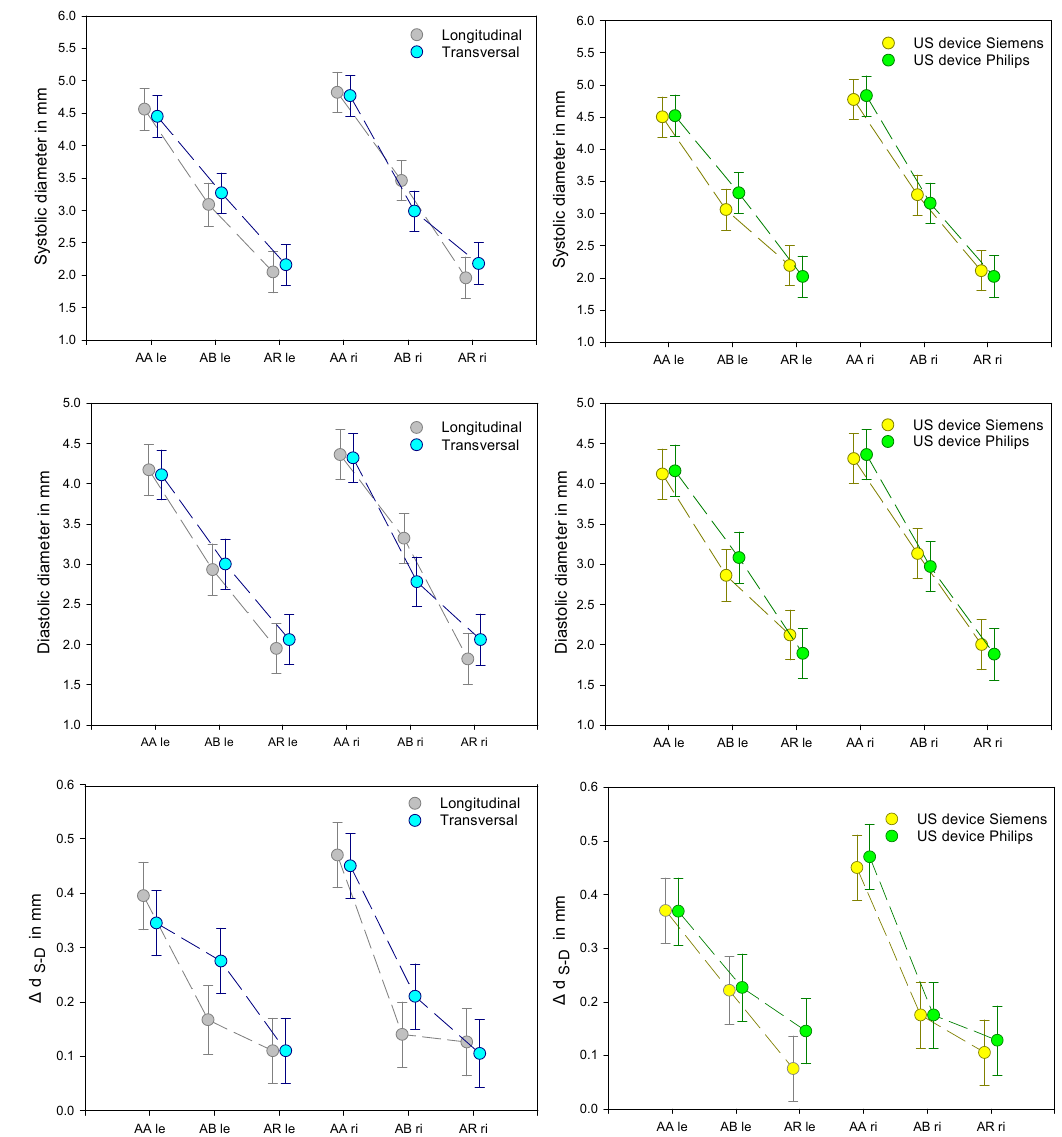
Figure 3. Course of the variables recorded directly with ultrasound (d S , d D , and ∆ d S-D ; d = diameter), measured in longitudinal and transversal alignment on the left side and with US devices from Siemens and Philips on the right side; each at the three selected measuring points A. axillaris (AA), A. brachialis (AB) and A. radialis (AR), specified for the left and right arm (x axis). Statistical significances are not entered in this overview. To delimit relevant differences, the mean values and the confidence intervals were selected.